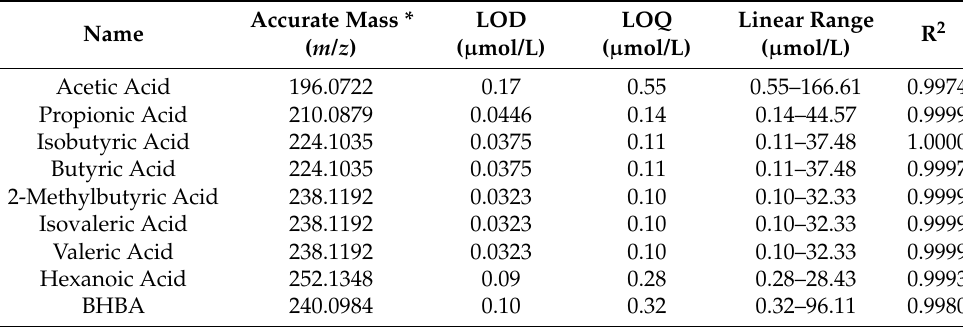
Table 1. Accurate mass, LOD, LOQ and linear range of derivatised SCFA and